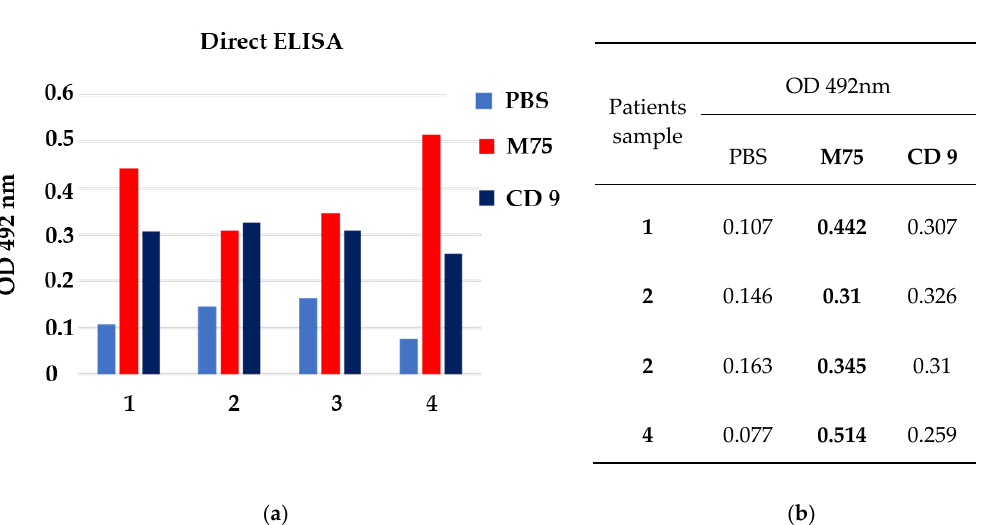
Figure A4. Characterization of exosomes from JIMT cells grown in hypoxia for 48 h. Expression of CA IX ( a ) and CD9 (specific marker of exosomes) ( b ) proteins was analyzed by Western blotting using specific antibodies.